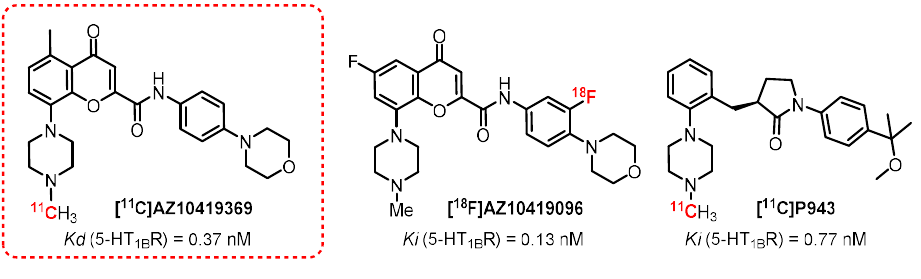
Figure 4. AZ10419369